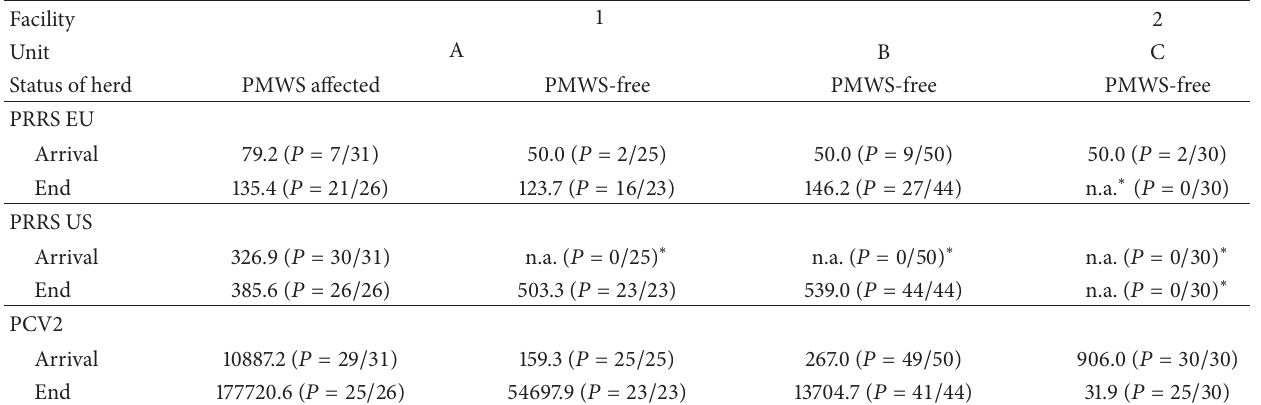
Table 4: Geometric mean of positive antibody titers (proportion of positive samples) against PRRSV EU, PRRSV US, and PCV2, at arrival and at the end of study II.